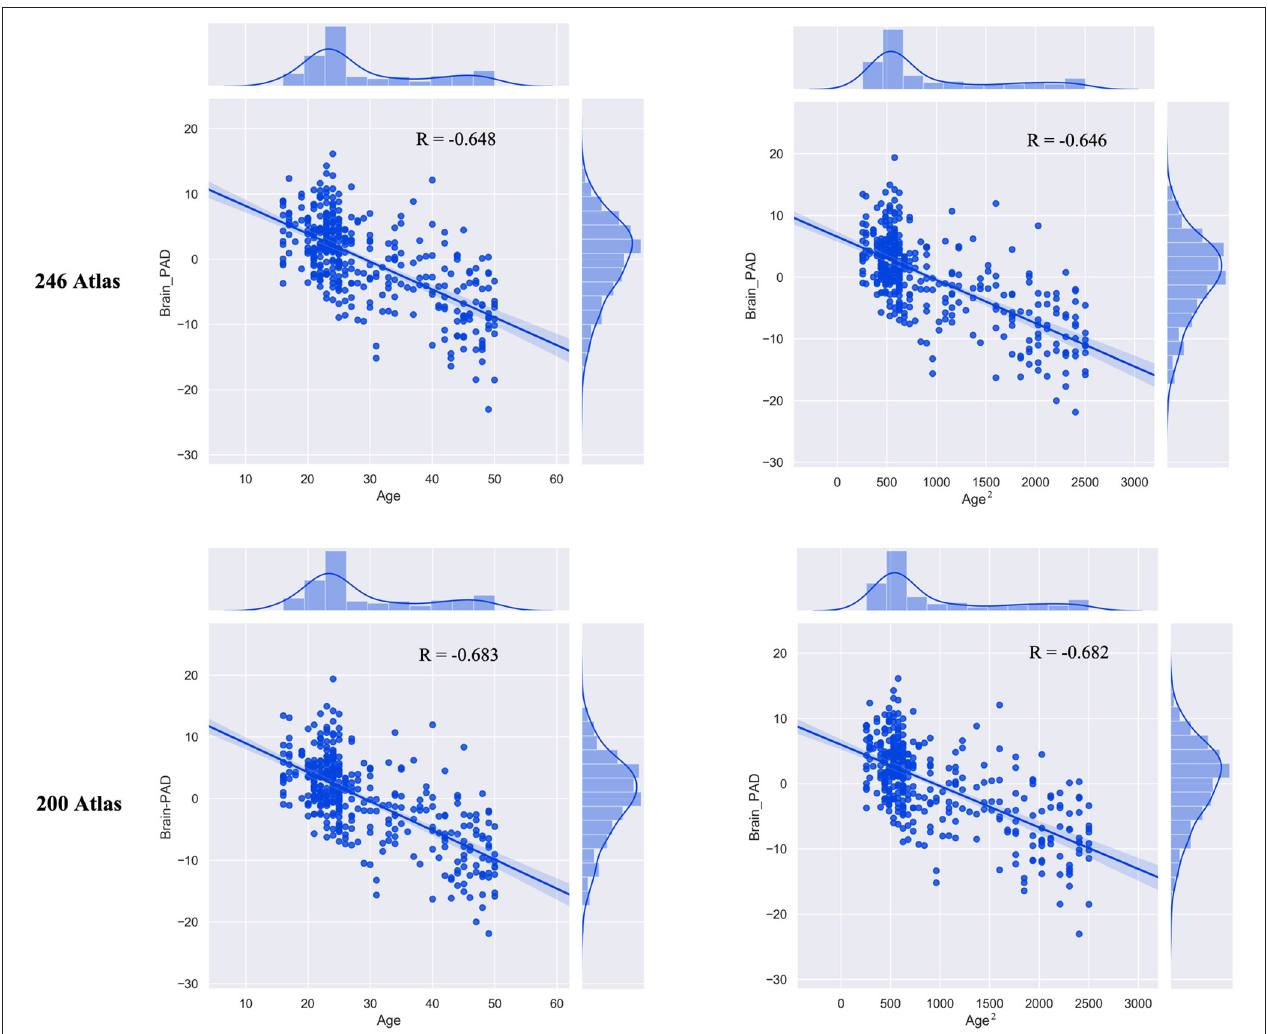
FIGURE 2 | The correlation between brain-PAD scores and age (age 2